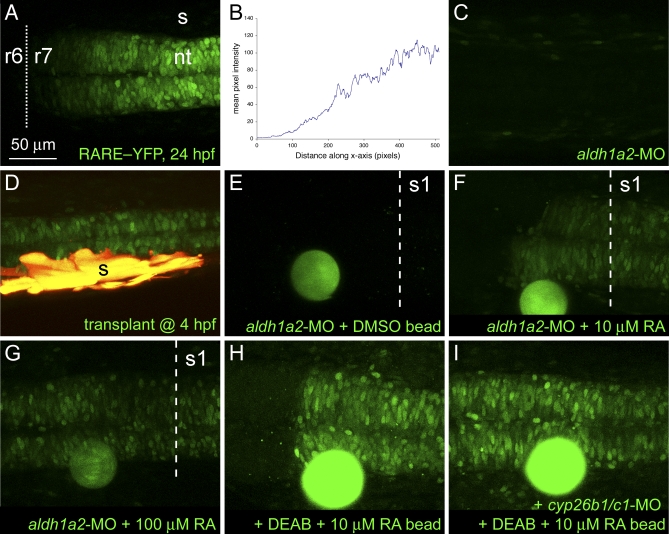
Responses of Embryos to Sources of RA.Long-range induction of a rare:yfp reporter. Confocal images of live embryos, dorsal view, anterior to the left.(A)
rare:yfp expression in posterior hindbrain and spinal cord at 24 hpf with an anterior boundary at r6/7.(B) Quantification of fluorescence intensities in (A).(C) Lack of YFP expression in an aldh1a2 morphant embryo.(D) Rescue of YFP expression in a morphant by somitic mesoderm (yellow) transplanted during gastrulation.(E–I) Bead implantation. RA-coated beads were implanted anterior to the first somite at 18–19 hpf and imaged at 23–24 hpf. A DMSO-coated bead (E) failed to rescue YFP expression, whereas beads soaked in either 10 μM (F) or 100 μM (G) RA induced YFP at distances of up to 200 μm.(H and I) Inhibition of both cyp26b1 and cyp26c1 in DEAB-treated embryos leads to a symmetrical response from the rare:yfp reporter to a bead soaked in 10 μM RA (compare [H] with [I]).The dotted line indicates the r6/7 boundary, the dashed line, the anterior border of somite 1. nt, neural tube; s, somites.